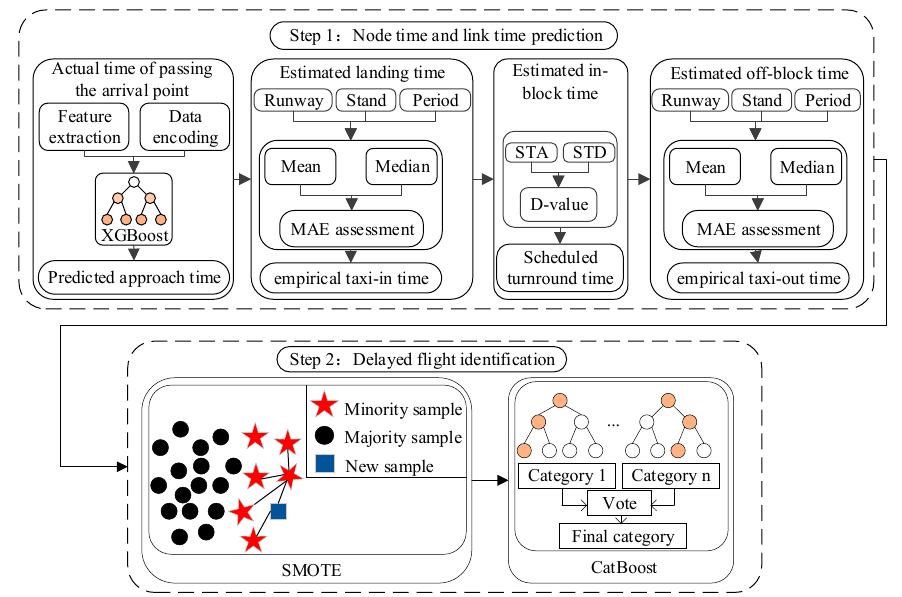
Figure 3. First phase prediction process.